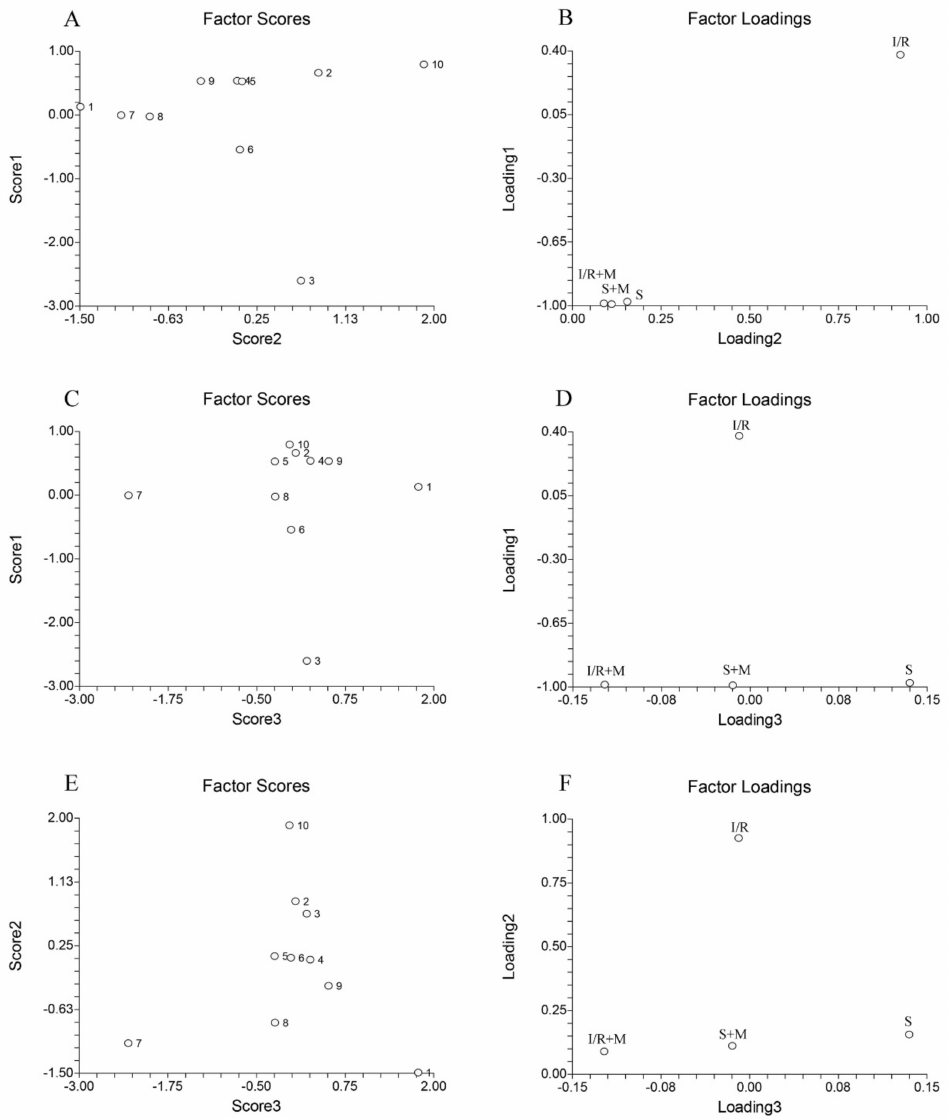
Figure 4. The score and the loading plots of kidney fatty acids principle component analysis. Group categories abbreviations: S—sham operated rat group; S + M—sham operated + meldonium rat